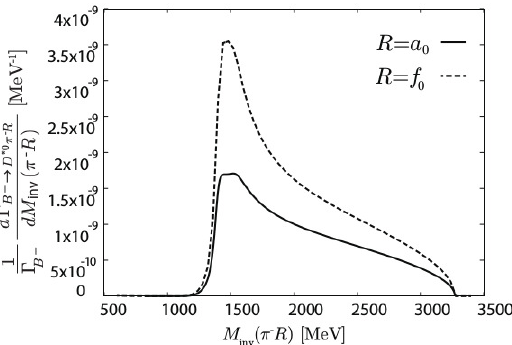
Figure 2: The mass distribution of B − → D ∗ 0 π − π 0 η (full line) and B − → D ∗ 0 π − π + π − (dashed